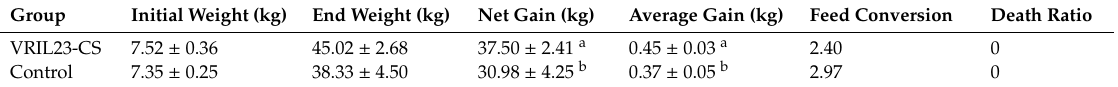
Table 3. E ff ect on the weight gain of piglets post inoculation (n =